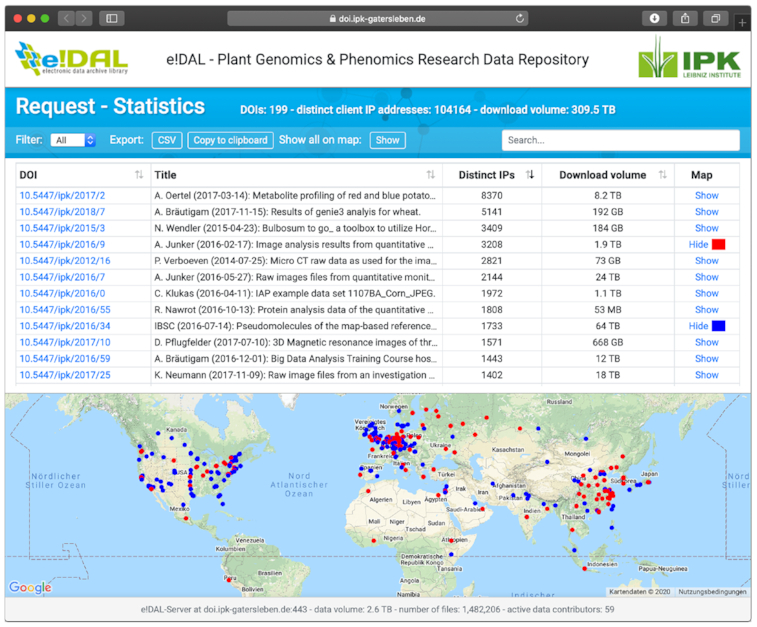
Example screenshot of the e!DAL embedded report page for the e!DAL-PGP repository showing the new layout and user interface. Several simple filter and search possibilities make it easier to look for specific datasets. An integrated world map gives the user an idea about the dissemination of the data.